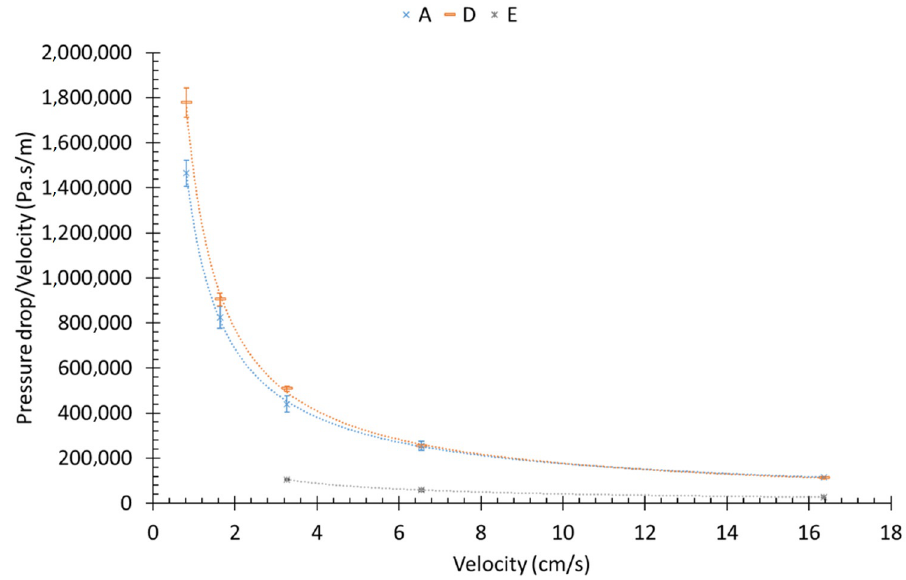
Figure 8. Aeraulic resistance, at the saturation, as a function of filtration velocity.